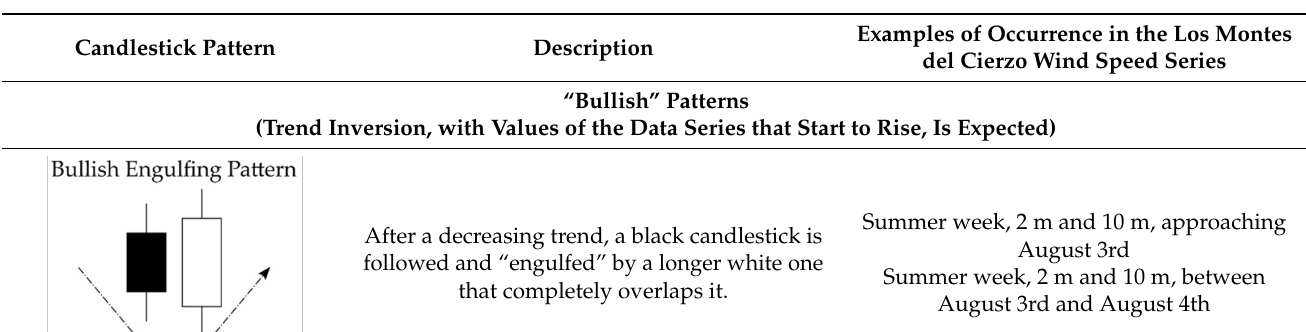
Table A1. Examples of some of the most used candlestick patterns for inversion, indecision and continuation, with their